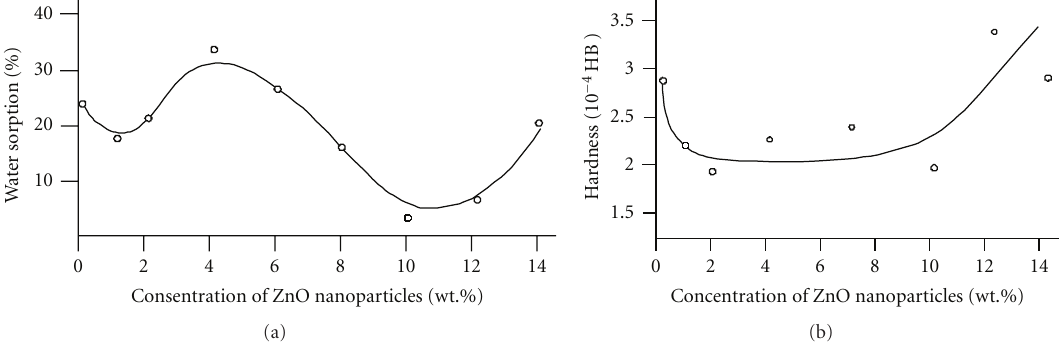
Figure 2: Sorption of water (a) and hardness (b) of composite BisA/2Carb (30/70) versus concentrations of